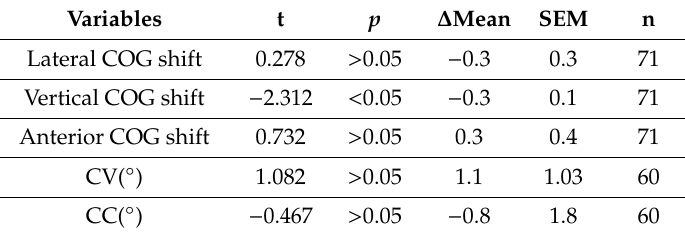
Table 5. Independent samples t -test of COG shift and CV and CC angles shift in boys and girls. Variables t p ∆ Mean SEM n Lateral COG shift 0.278 Vertical COG